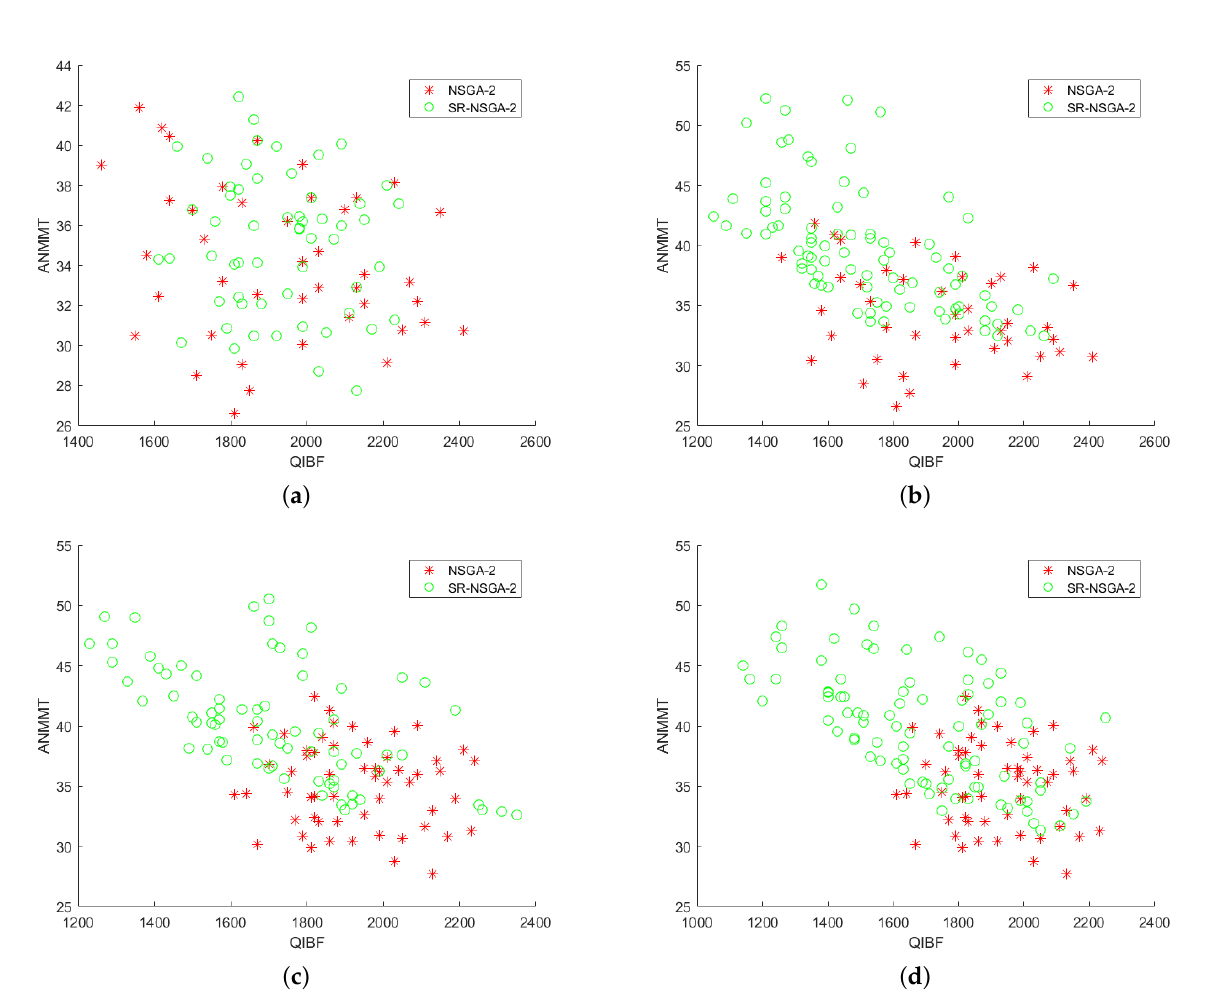
Figure 17. Index analysis chart of ASS and